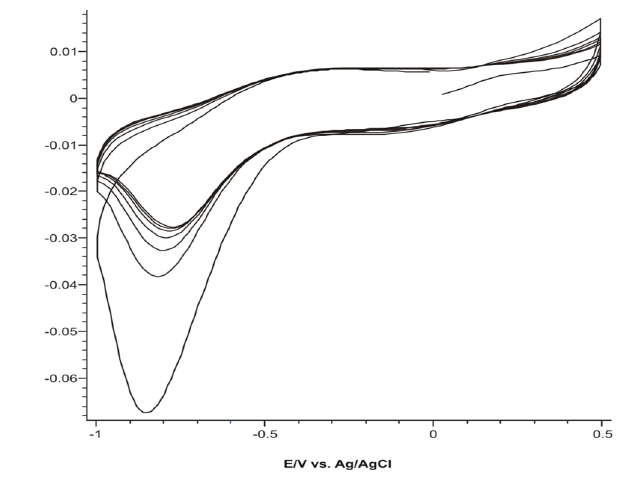
Figure 7. Six successive cyclic voltammograms of the PPy/FeCN sensor in 0.1 M KCl solution.